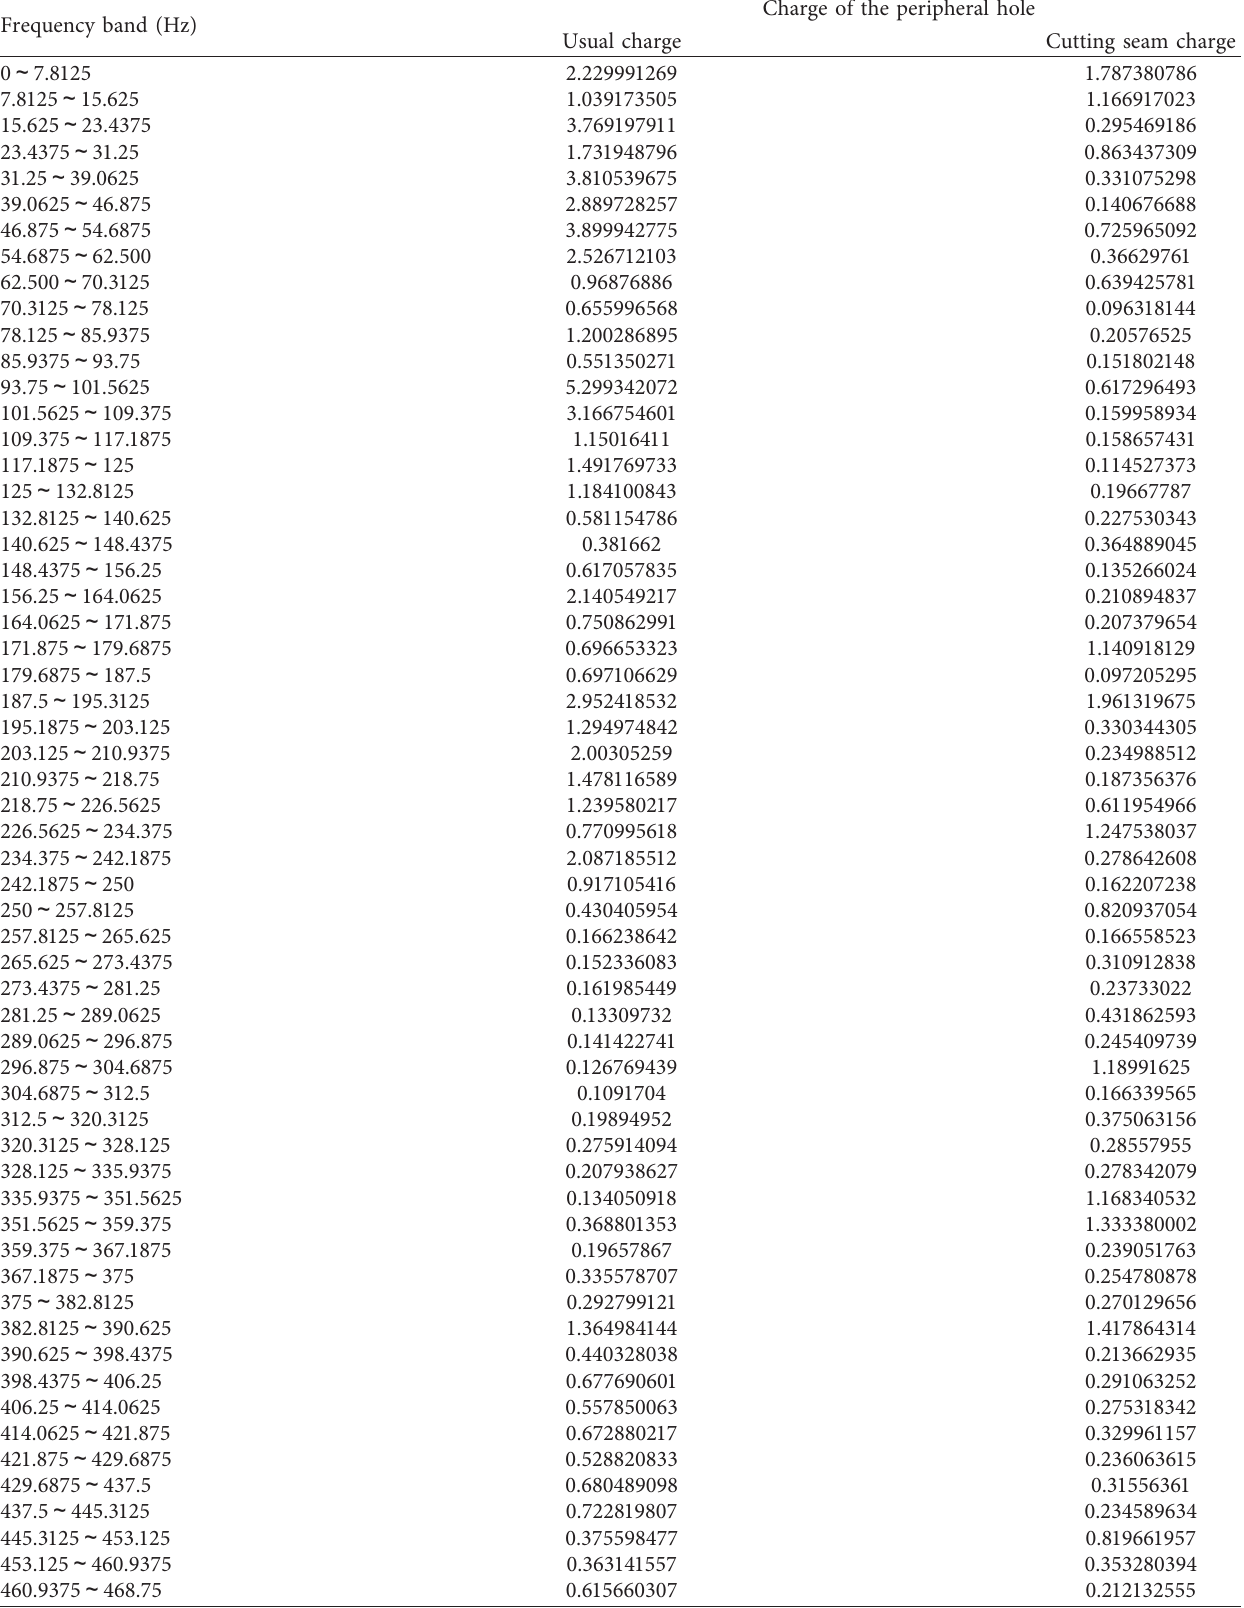
Table 2: Energy distribution percentage of blasting vibration signals with different charges